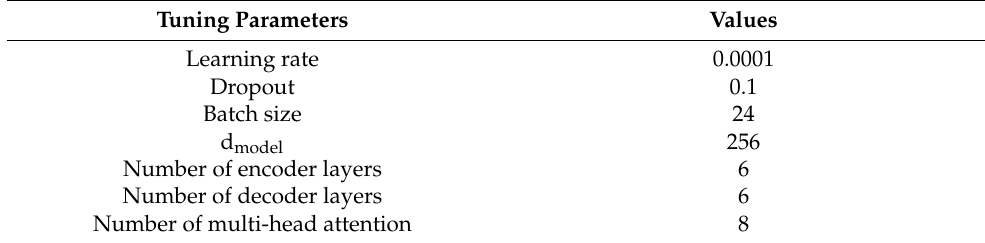
Table 4. The adopted parameters of the Transformer